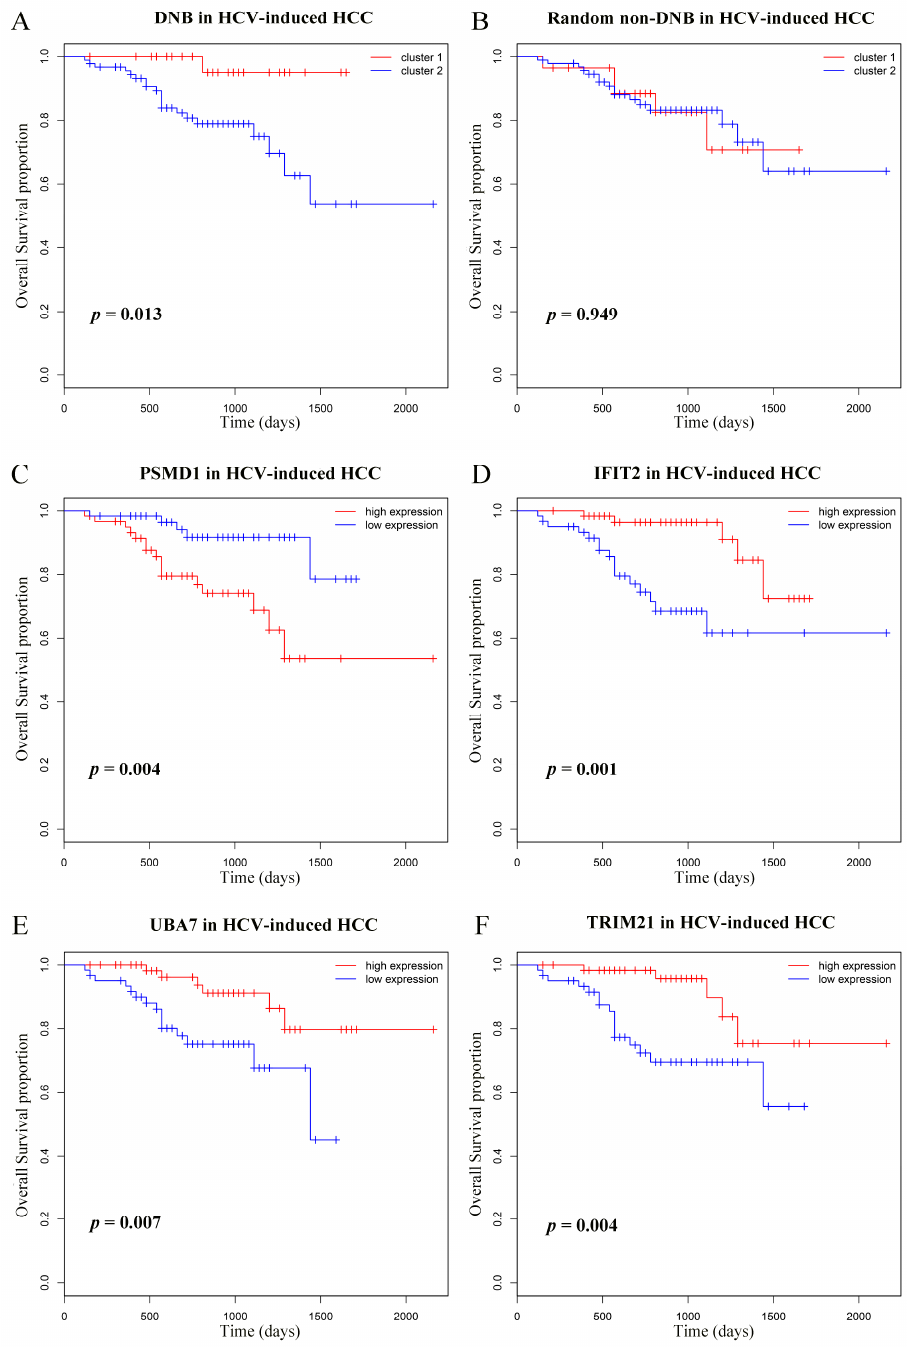
Figure 5. Kaplan–Meier overall survival curves for the HCV-induced HCC patients based on DNB. Illustration of prognostic difference between the two groups identified by the DNB ( A ) and by random non-DNB ( B ). ( C – F ) The survival curves of patients with different expression levels of representative DNB members. Patients were divided into low- and high-expression groups according to the median